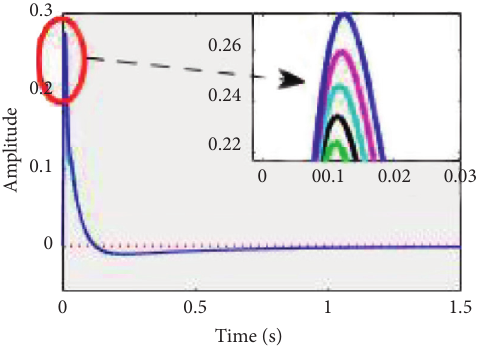
Figure 10: Unit step response curve cluster II of e a to T h .